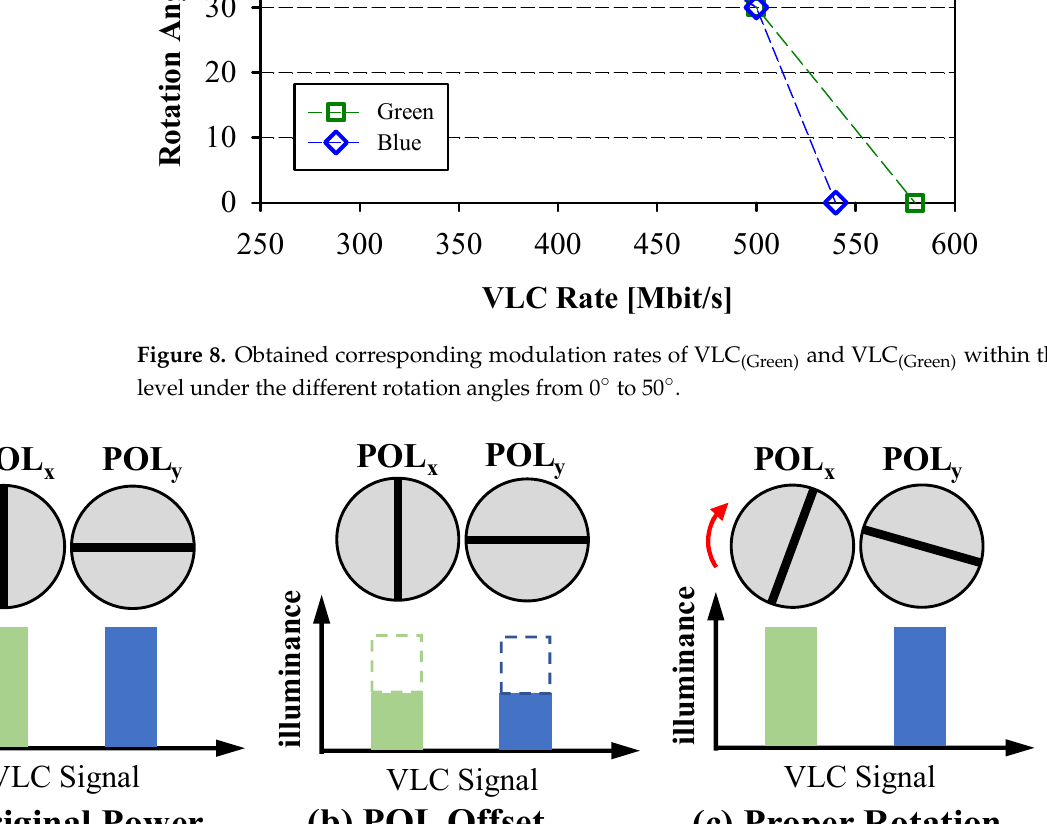
Figure 9. Schematic diagram of the POL’s rotation control for decoding dual-polarized VLC traffics.